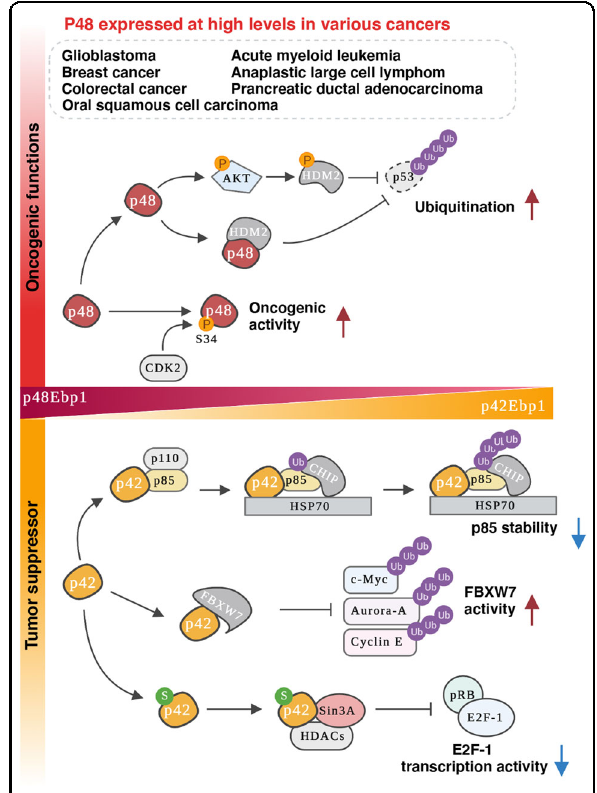
Fig. 3 Distinct functions of EBP1 isoforms in cancer. Two EBP1 isoforms have different functions in various human cancers, along with differential binding partners. p48 (upper panel) is expressed at high levels in human patients with glioblastoma or breast cancer. Oncogenic effects of p48 result from, in part, downregulation of p53 protein levels by enhancing HDM2-mediated ubiquitination of p53 and subsequent degradation of p53 in cancer cells. In addition, CDK2- dependent phosphorylation of N-terminal S34 on p48 is associated with cancer development and progression. In contrast, p42 (lower panel) acts as a tumor suppressor, and its expression is extremely low in tumor cells, which is similar to that of other tumor suppressors. p42 inhibits PI3K activity, leading to HSP70/CHIP-mediated degradation of the p85 subunit of PI3K, thereby suppressing tumor growth. P42 also enhances the tumor suppressor function of FBXW7, increasing the association of FBXW7 and its target proteins, such as c-Myc, Aurora-A, or Cyclin E. Moreover, P42 binds to Sin3A and HDAC2, leading to repression of the transcriptional activity of